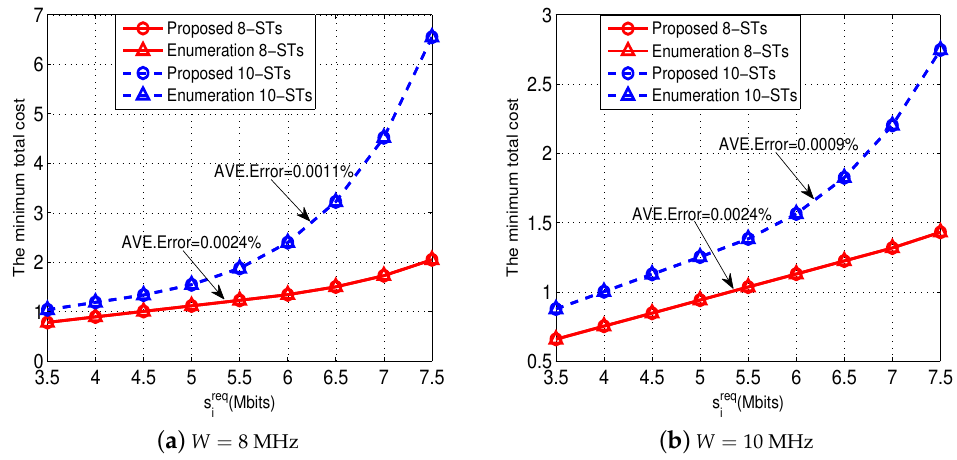
Figure 4. Effectiveness of the Algorithms 1 and 2 in solving Problem (P1- m